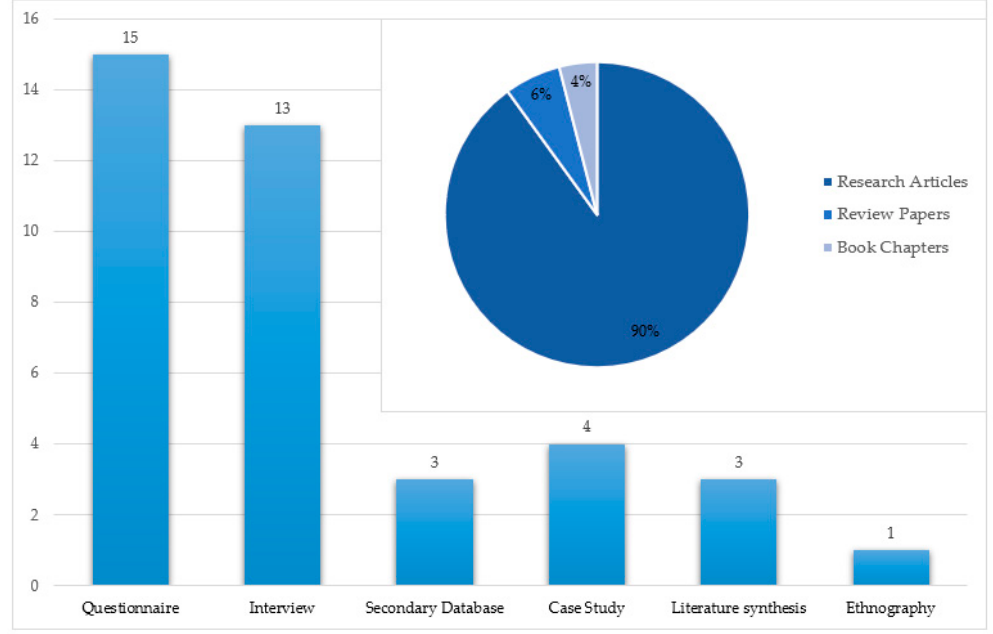
Figure 3. Data source and document types of reviewed articles in the current study.